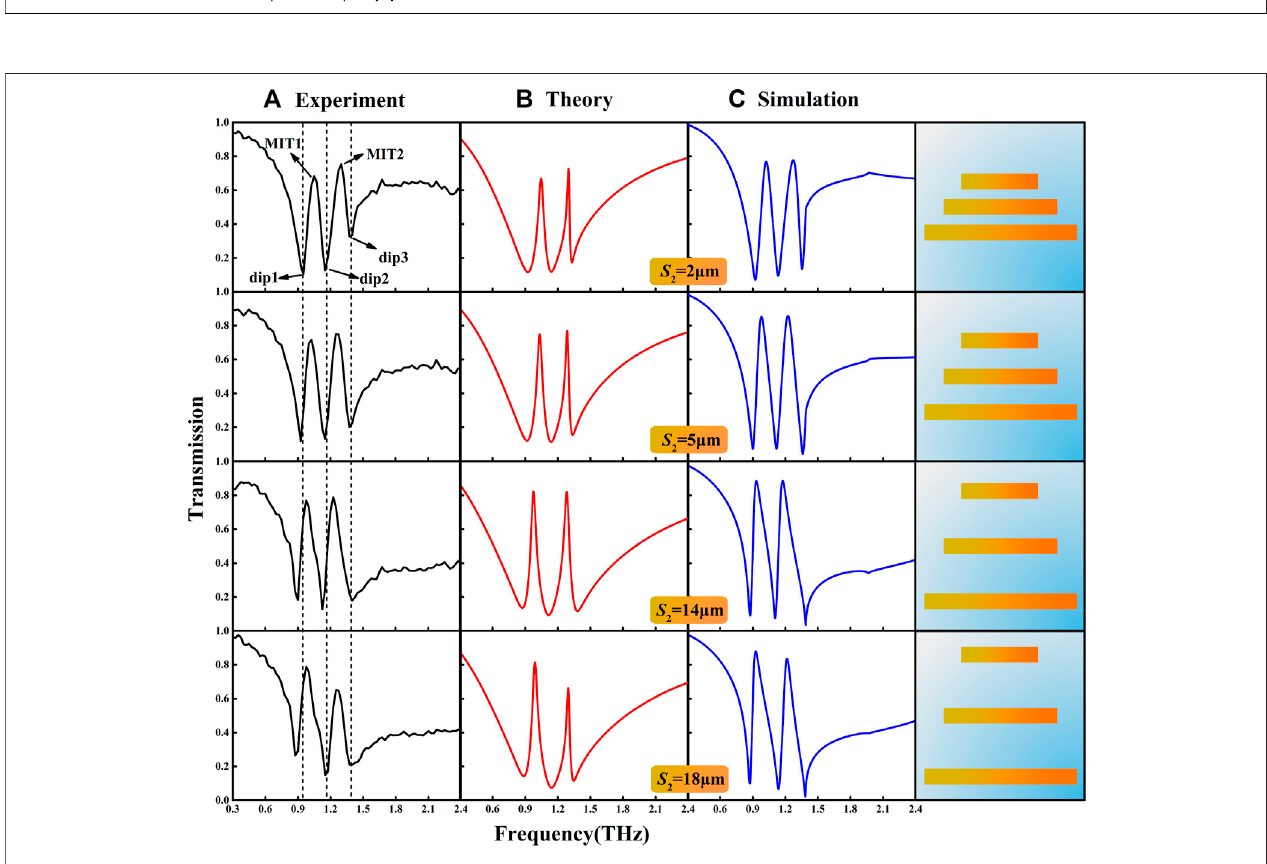
FIGURE 5 | Evolution of transmission spectra of sample M123 with S 2 of 2, 5, 14, and 18 μ m, respectively. (A) Experimental transmission spectra. (B) Corresponding theoretical fi tting results with the Lorentz oscillator model. (C) Numerical simulation spectra.